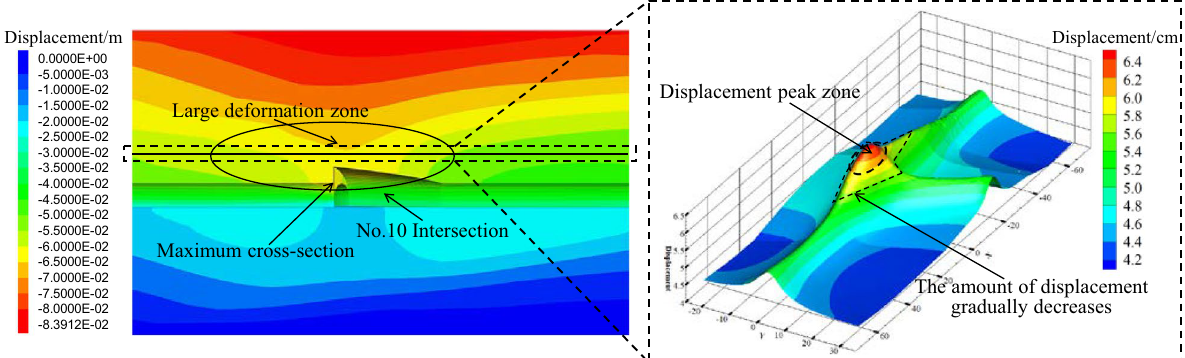
Fig. 14 Vertical displacement cloud of roadway